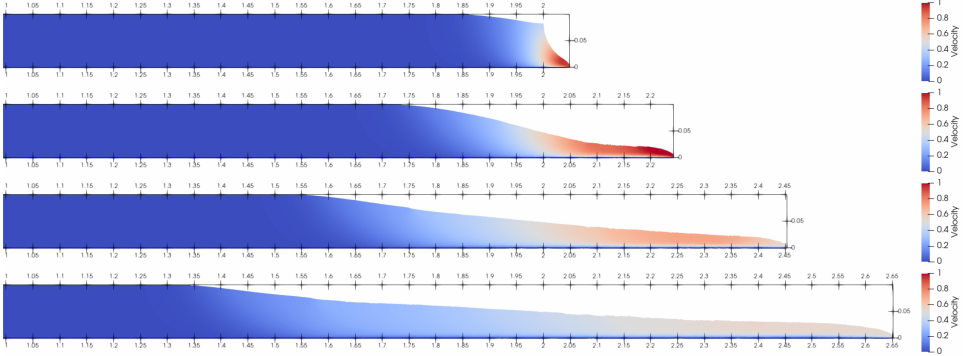
Figure 7. Dam break snapshots for time instances t = 0.1, 0.3, 0.6, 1.0 s, with the plotted velocity